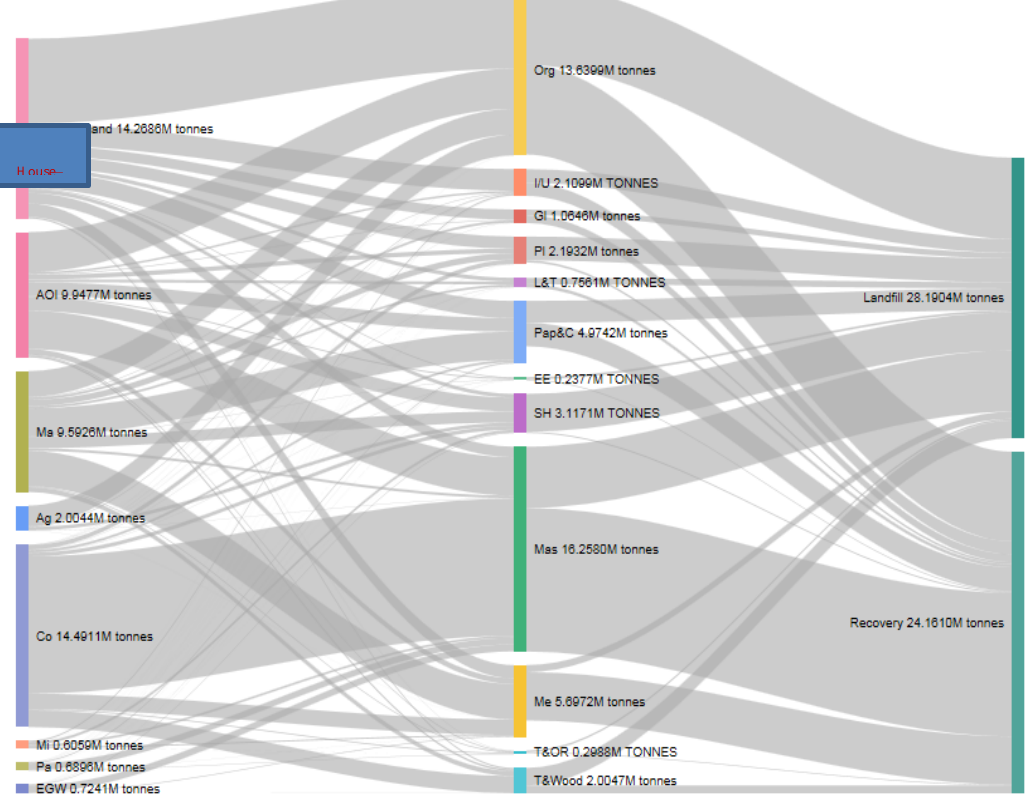
Figure 8. Physical flow of waste footprints in the Australian waste input output (WIO) table of 2010–2011; waste generated by intermediate sectors (left) and the households (left), sorted into 12 categories (middle), and dealt with by two waste treatment methods (right). Final demand refers to the households. Agriculture, forestry, and fishing = AG; Mining = MI; Manufacturing = MA; Electricity, gas, and water = EGW; Waste management services = WMS; Construction = CO; Public administration = PA; All other industry = AOI.